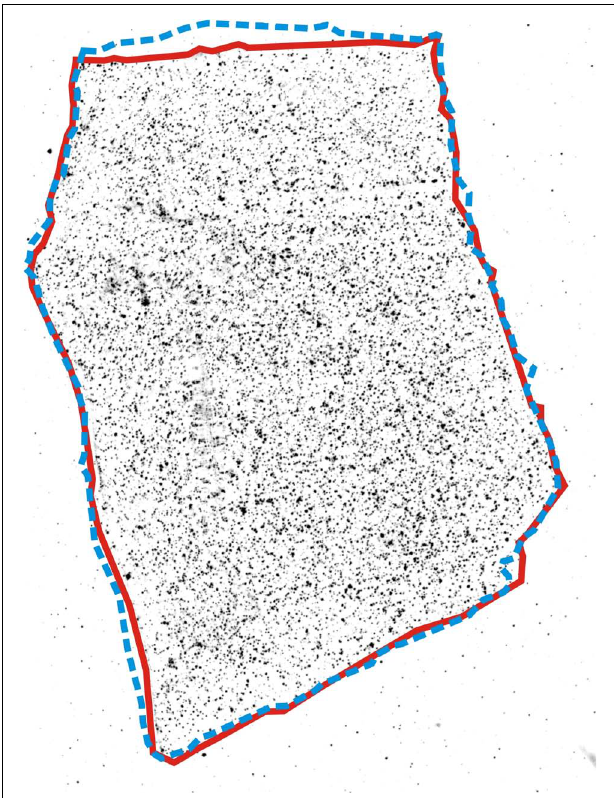
FIGURE 5 | Boundaries of the seeded particle in mode “a” experiment identified based on method (1) by contrast with the surrounding fluid without particles, red solid line, and based on methods (2) and (3), which had similar results, blue dashed